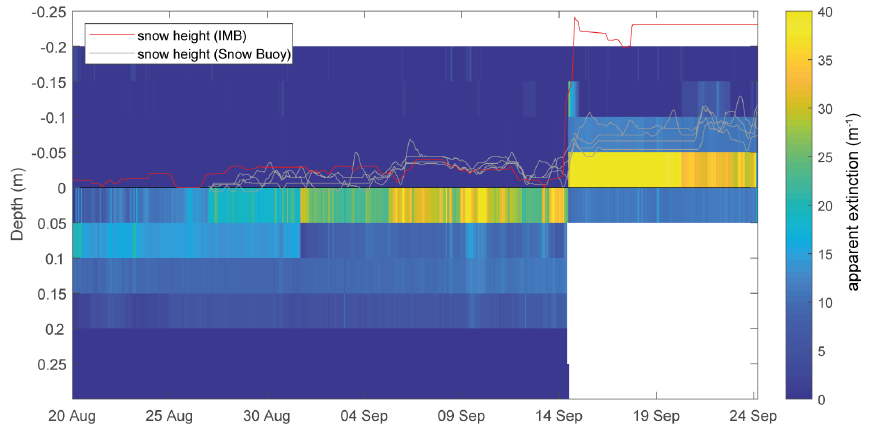
Figure 7. Close-up of the vertical profiles of apparent extinction coefficients calculated from light chain data in the uppermost sensor pairs. Snow height measured from the neighboring acoustic pinger of the ice-mass-balance buoy (red) and from the four acoustic pingers of the snow buoy (gray lines). The black line indicates the interfaces between air and ice during chain deployment.